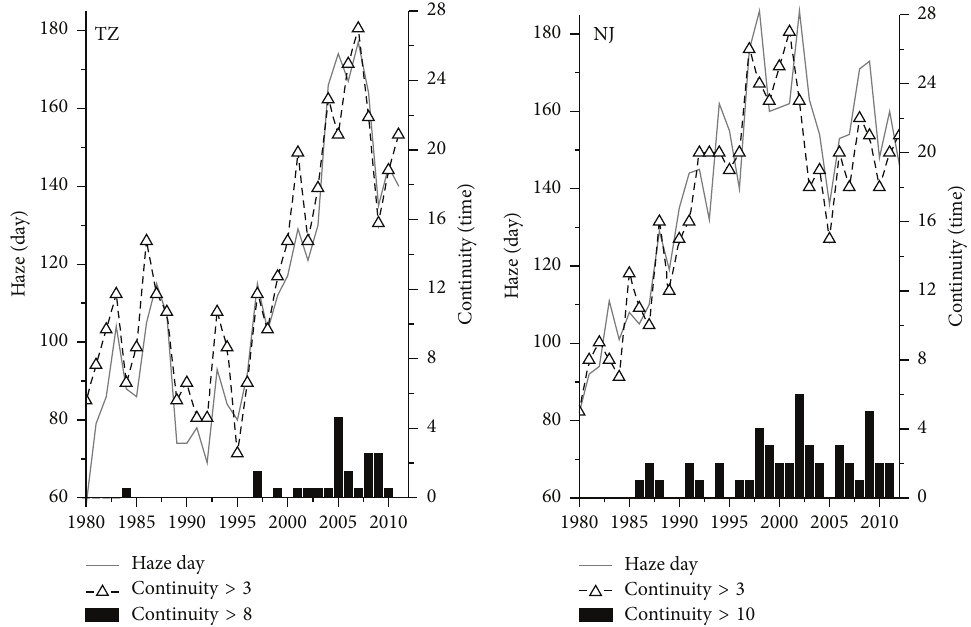
Figure 5: Continuous hazy day in Taizhou and Nanjing.